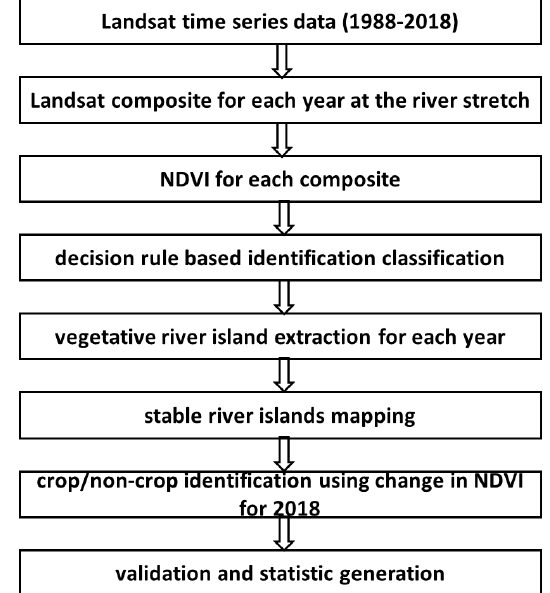
Figure 2. Methodology